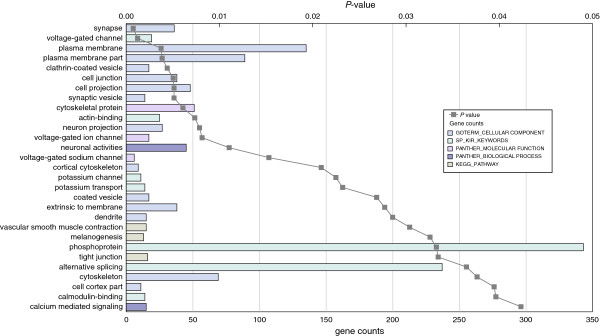
Overrepresented gene ontology categories for differentially expressed genes in the En2-/-adult hippocampus. Differentially expressed genes (n = 862) were analyzed for enrichment in gene ontology categories using public databases with a Benjamini corrected P value cutoff of 0.05. Further details regarding the figure and inset are described in the legend to Figure 2. Data details are also reported in Additional file 5.